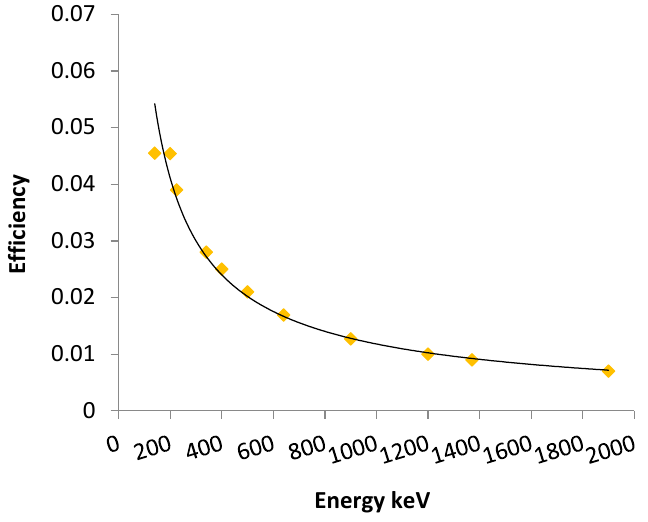
Figure 1. Efficiency calibration curve for the high